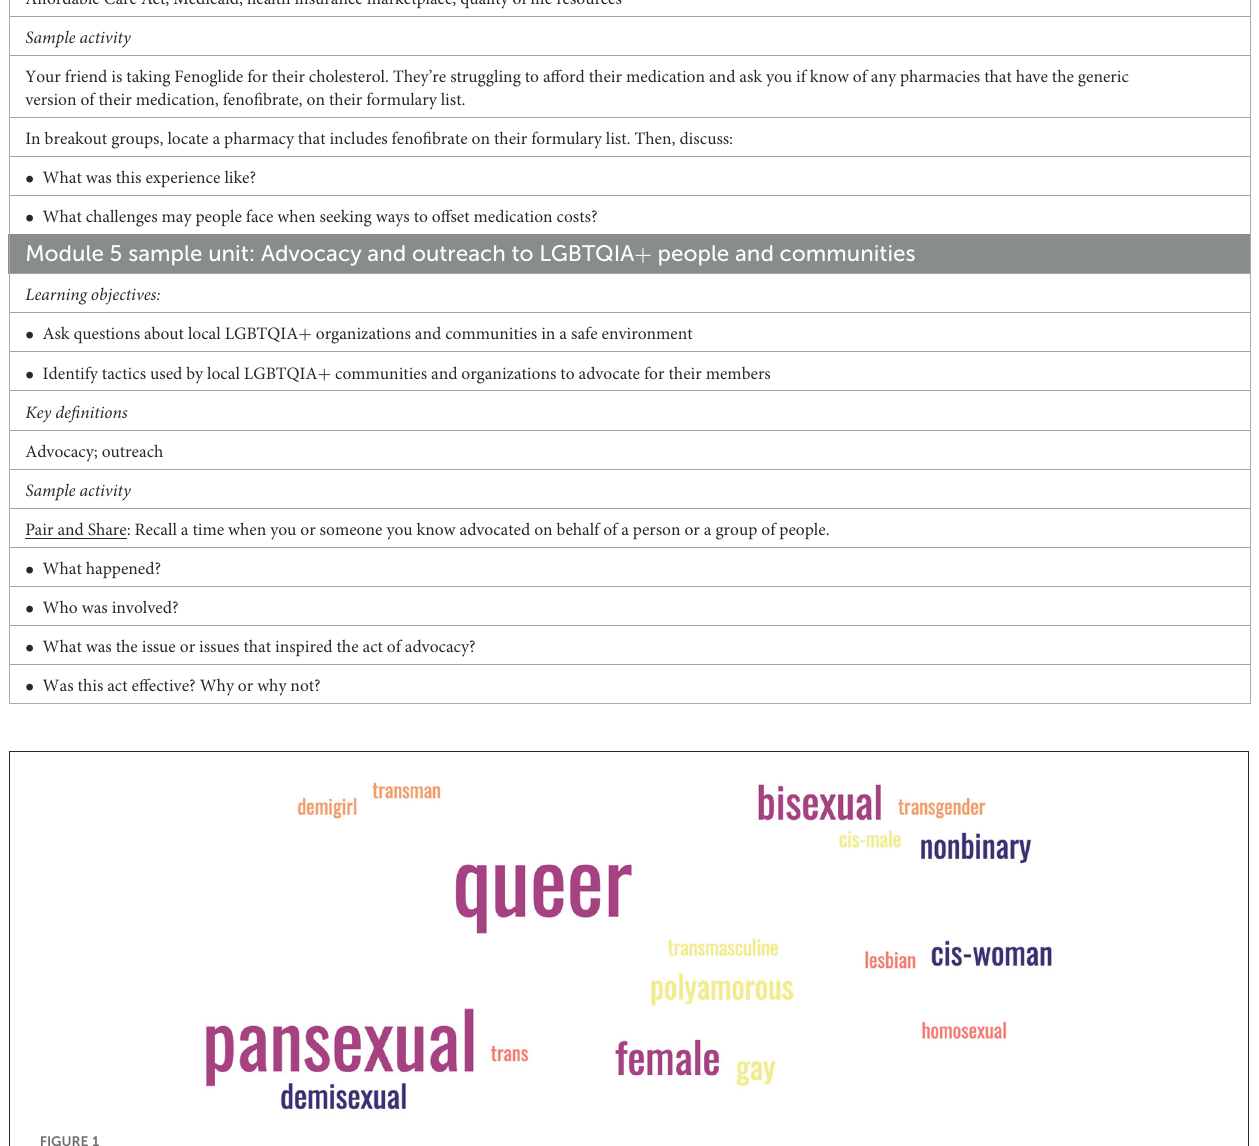
occurred in March-April 2022. Table 3 displays sample items from each of the feedback